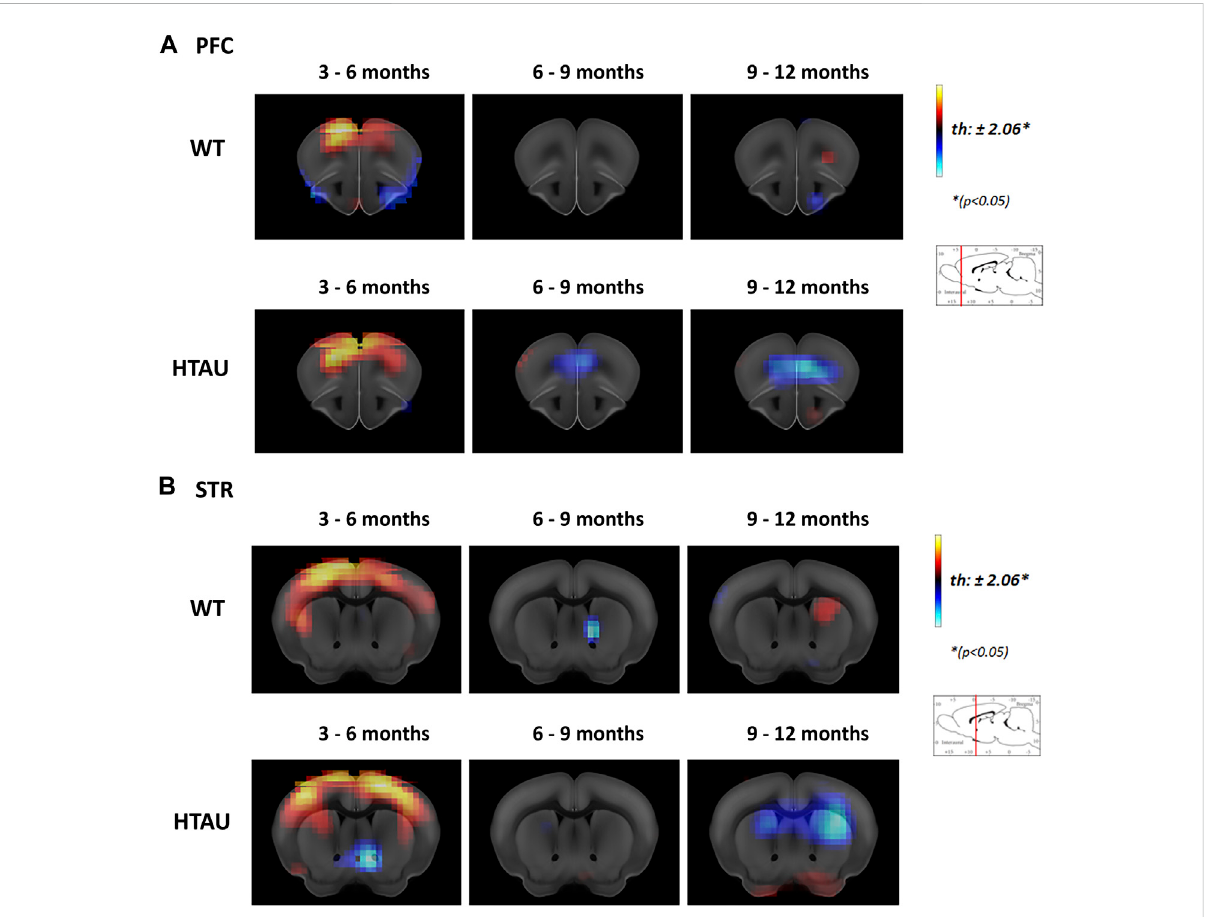
FIGURE 2 Age-related changes in brain metabolism in htau mice. In vivo brain glucose uptake was analysed by [18F]-FDG preclinical PET imaging in htau and WT mice at 3-, 6-, 9- and 12-month-old. The result is shown as a statistical parametric comparison between the groups. Color changes represent a statistical change, determined by t-test comparisons (* p < 0.05) between the groups compared (indicated in each panel). Red-yellow look up table side indicates [18F]-FDG uptake increases, while blue indicates uptake decrease. Coronal sections showing [18F]-FDG uptake changes in the Prefrontal cortex (A) and striatum (B) of htau and WT mice, between 3 and 6, 6 to 9 and 6 – 12 months old (WT n = 11; htau n = 9). Images shown represent T-maps of brain metabolism compared to former recorded activity of the same